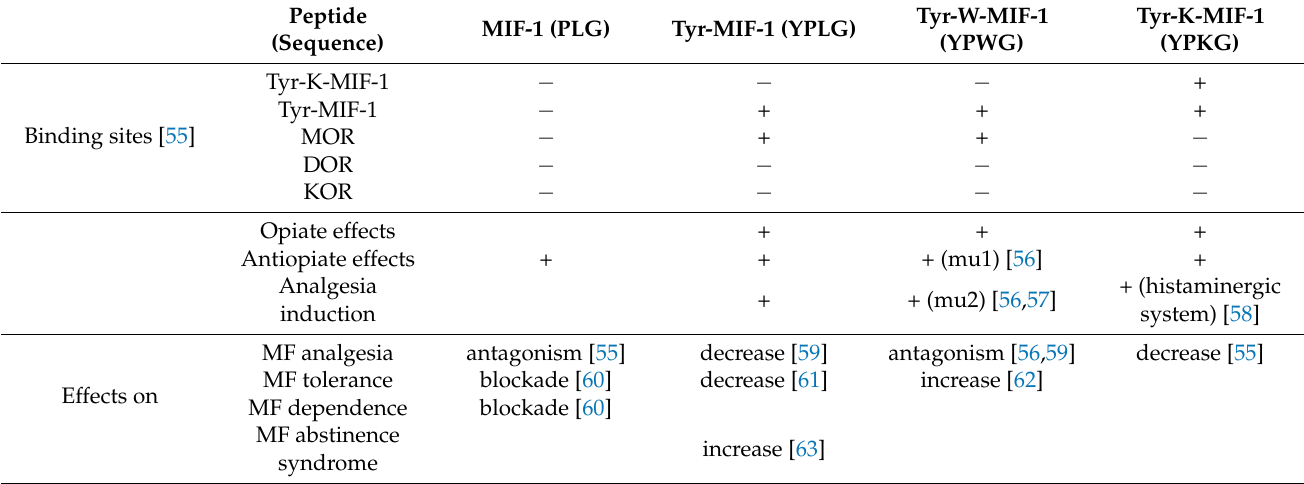
Table 2. Tyr-MIF-1 family peptides; binding sites and impact on different morphine (MF)